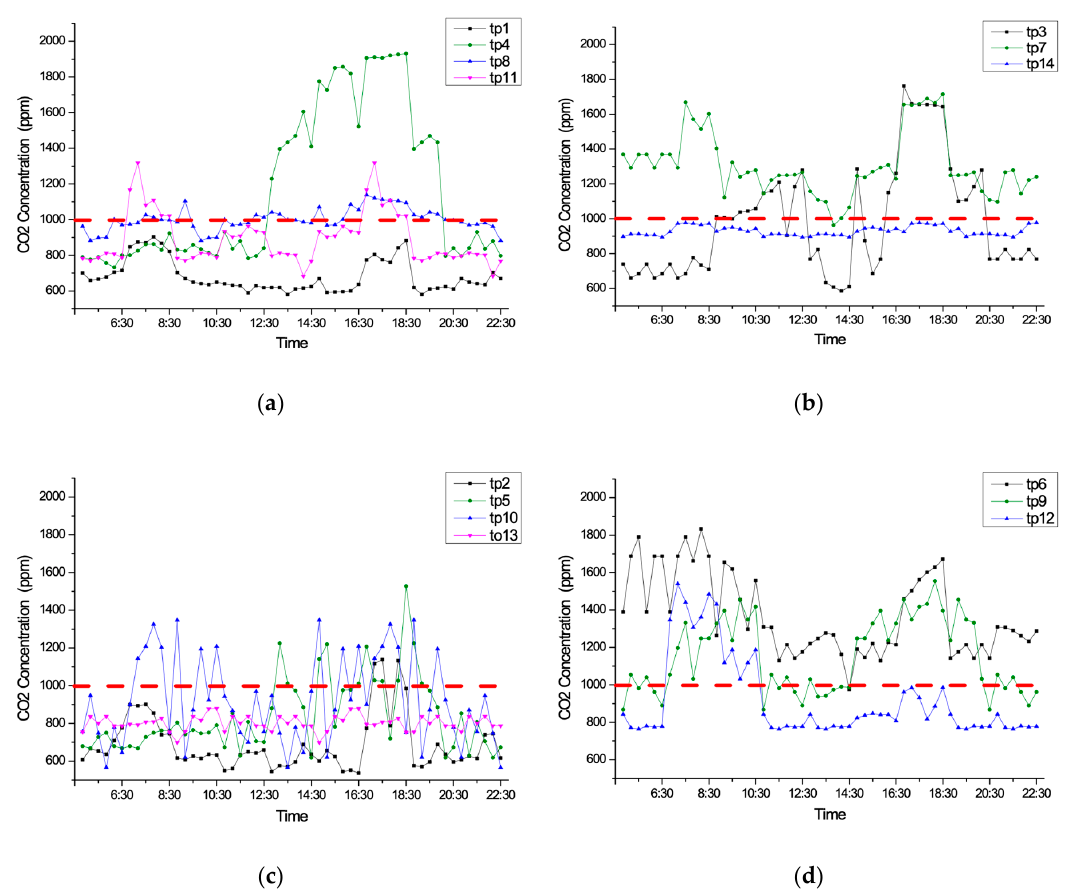
Figure 12. Comparison curves of hourly CO 2 concentration data for each point during the monitoring day. ( a ) Middle tubular space; ( b ) Tube entrance (connection to building); ( c ) Tube entrance (connection to subway); ( d ) Station hall. c: PM2.5/PM10